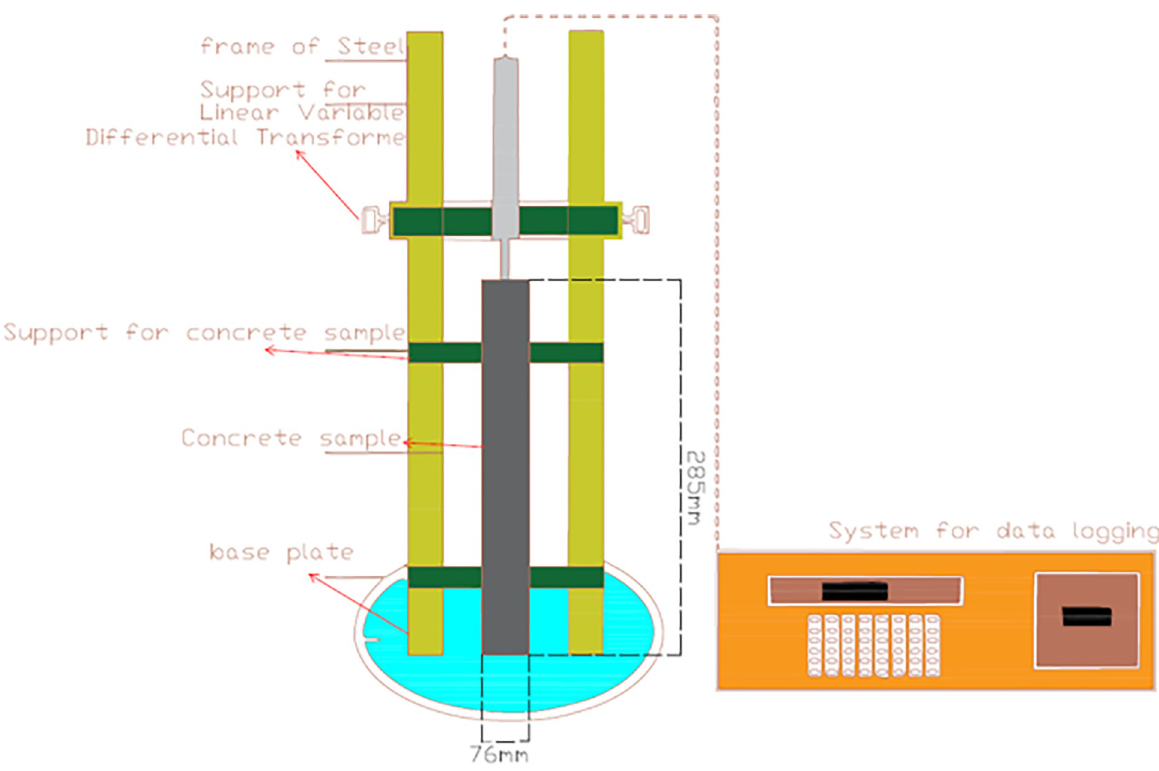
Fig 6. Test setup for drying